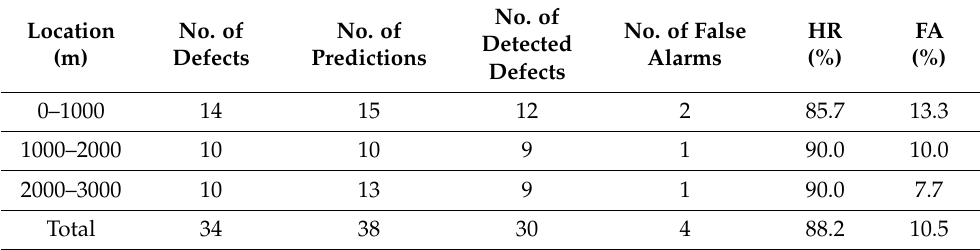
Figure 10. WPS values and detected positions. Table 1. Design weight of tilting train.